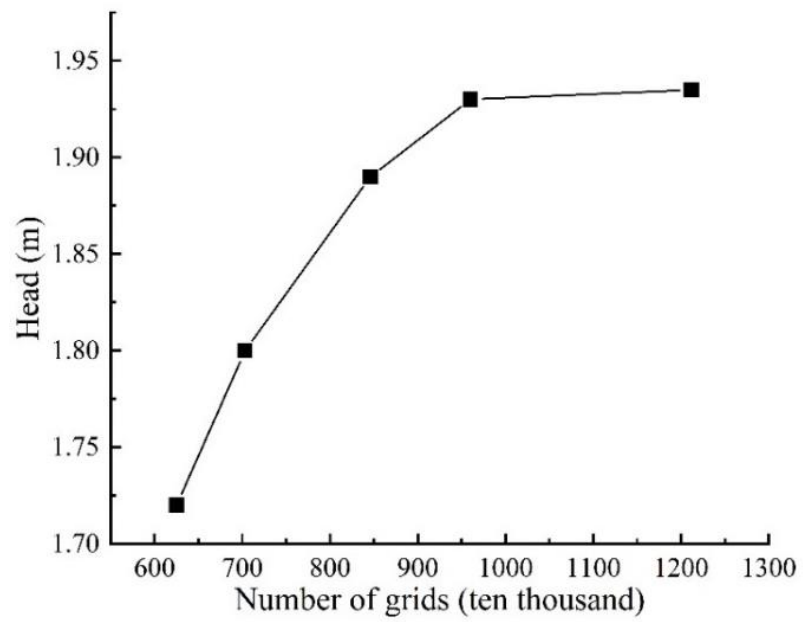
Figure 5. Grid independence analysis.